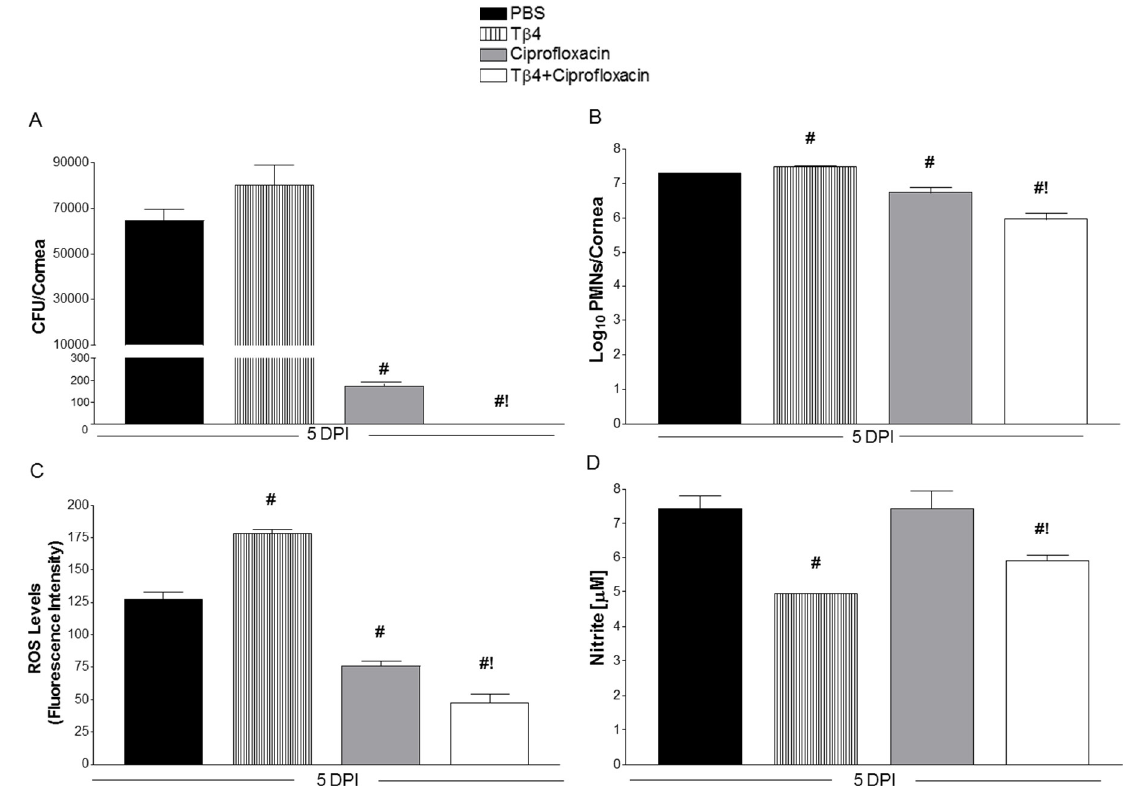
Figure 3. ( A ) Quantitation of viable bacteria detected at 5 days p.i. from corneas of PBS-, T β 4-, ciprofloxacin-, and T β 4 + ciprofloxacin-treated animals. Results are reported as CFU/cornea ± SD. ( B ) PMN numbers as correlated from levels of MPO detected from corneal lysates after infection. Results are reported as log 10 PMNs/cornea ± SD. ( C ), ROS levels determined by fluorescent values (DCFH-DA values—negative control values). Fluorescent values were acquired by subtraction of negative control values from DCFH-DA values. Results are reported as mean intensity ± SD. ( D ) Nitrite levels as measured from corneal lysates after infection. Results are reported as µ M nitrite/cornea ± SD. N = 5 corneas/group/time point. # P < 0.05 versus PBS; ! P < 0.05 versus ciprofloxacin.